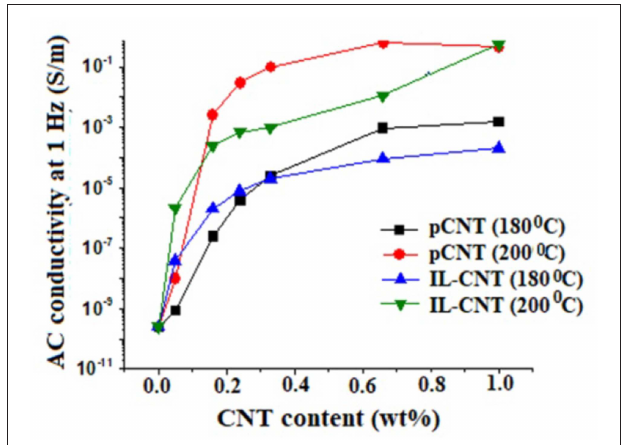
FIGURE 9 | AC conductivity at 1Hz of PS/PBAT composites as a function of pCNT or IL-CNT content and molding temperature.